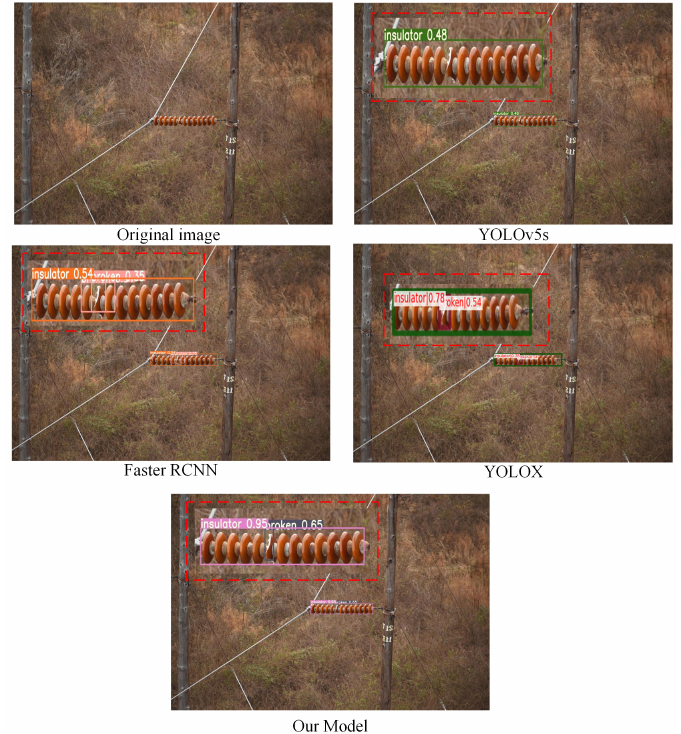
Figure 17. Small-object detection experimental results.